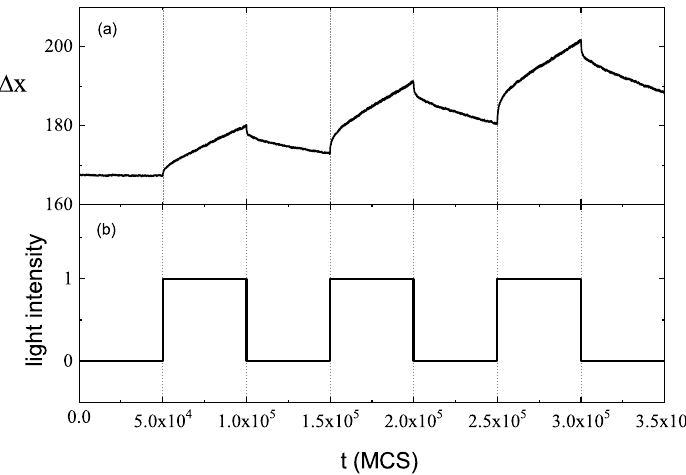
Figure 28. Plot of elongation ∆ x of the host–guest system in function of MC time ( a ), driven by periodic modulation of light intensity ( b